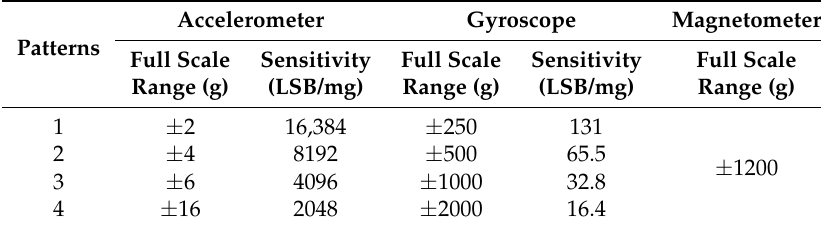
Table 1. Specifications of MPU9150.